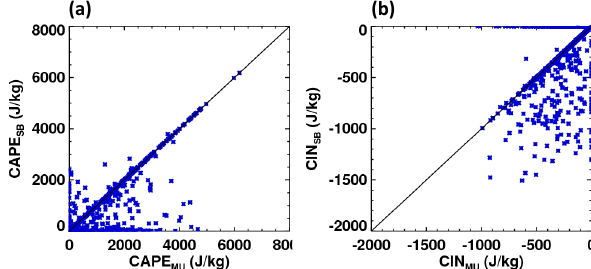
Figure 11. Scatterplots of convective indices, computed using RH- corrected soundings, comparing estimates for surface parcel charac- teristics defined by the level with the maximum virtual temperature in the lowest kilometer (MU) and the lowest level in the sounding (SB) for (a) CAPE and (b)